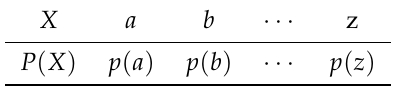
Table 1. Probability distribution of